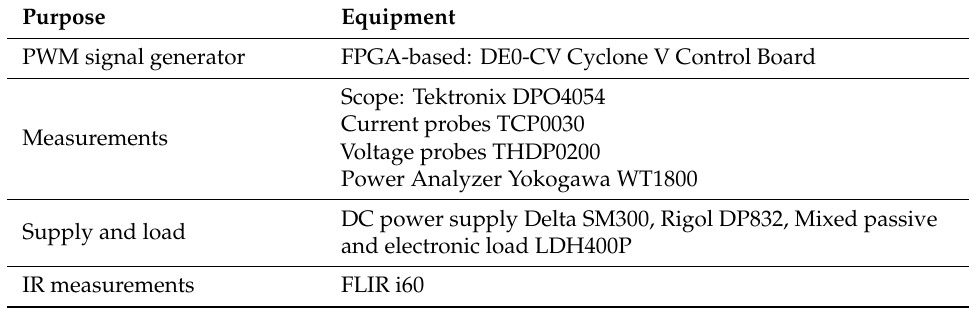
Table 4. Parameters of the laboratory test setup.